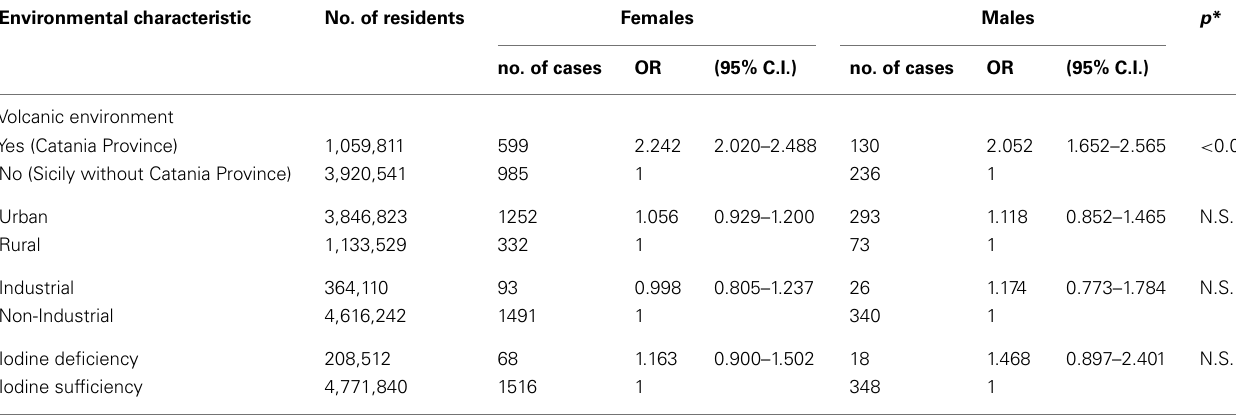
Table 3 |Thyroid cancer incidence in Sicily: odds ratio by environmental